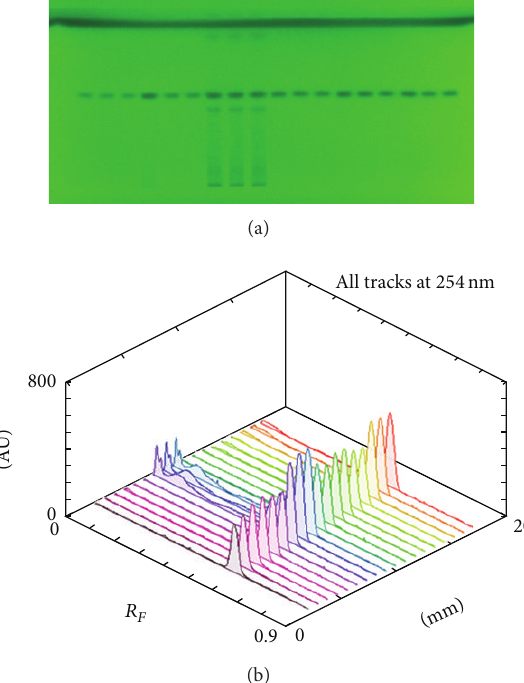
Figure 2: Chromatographic plate (a) and 3D chromatograms (b) of caffeine standard (six tracks from the left and nine from the right) and sample of mate (middle